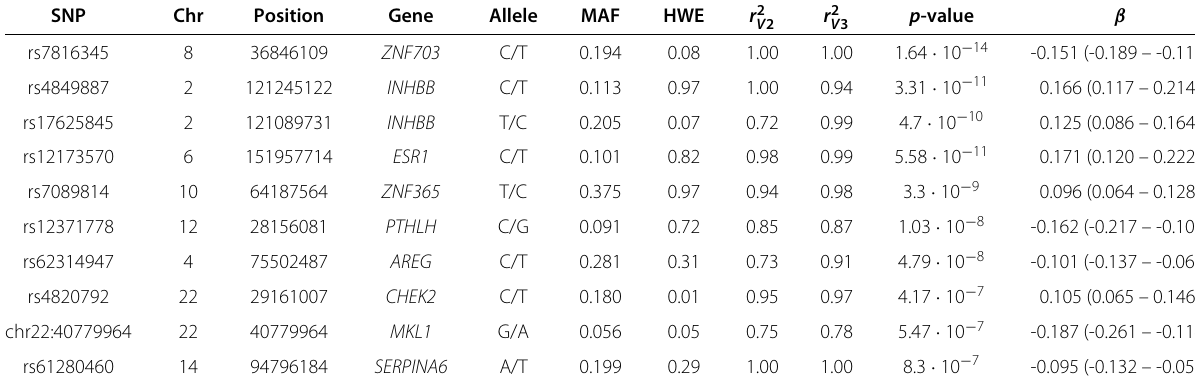
r 2 p -value β V 2 V 3